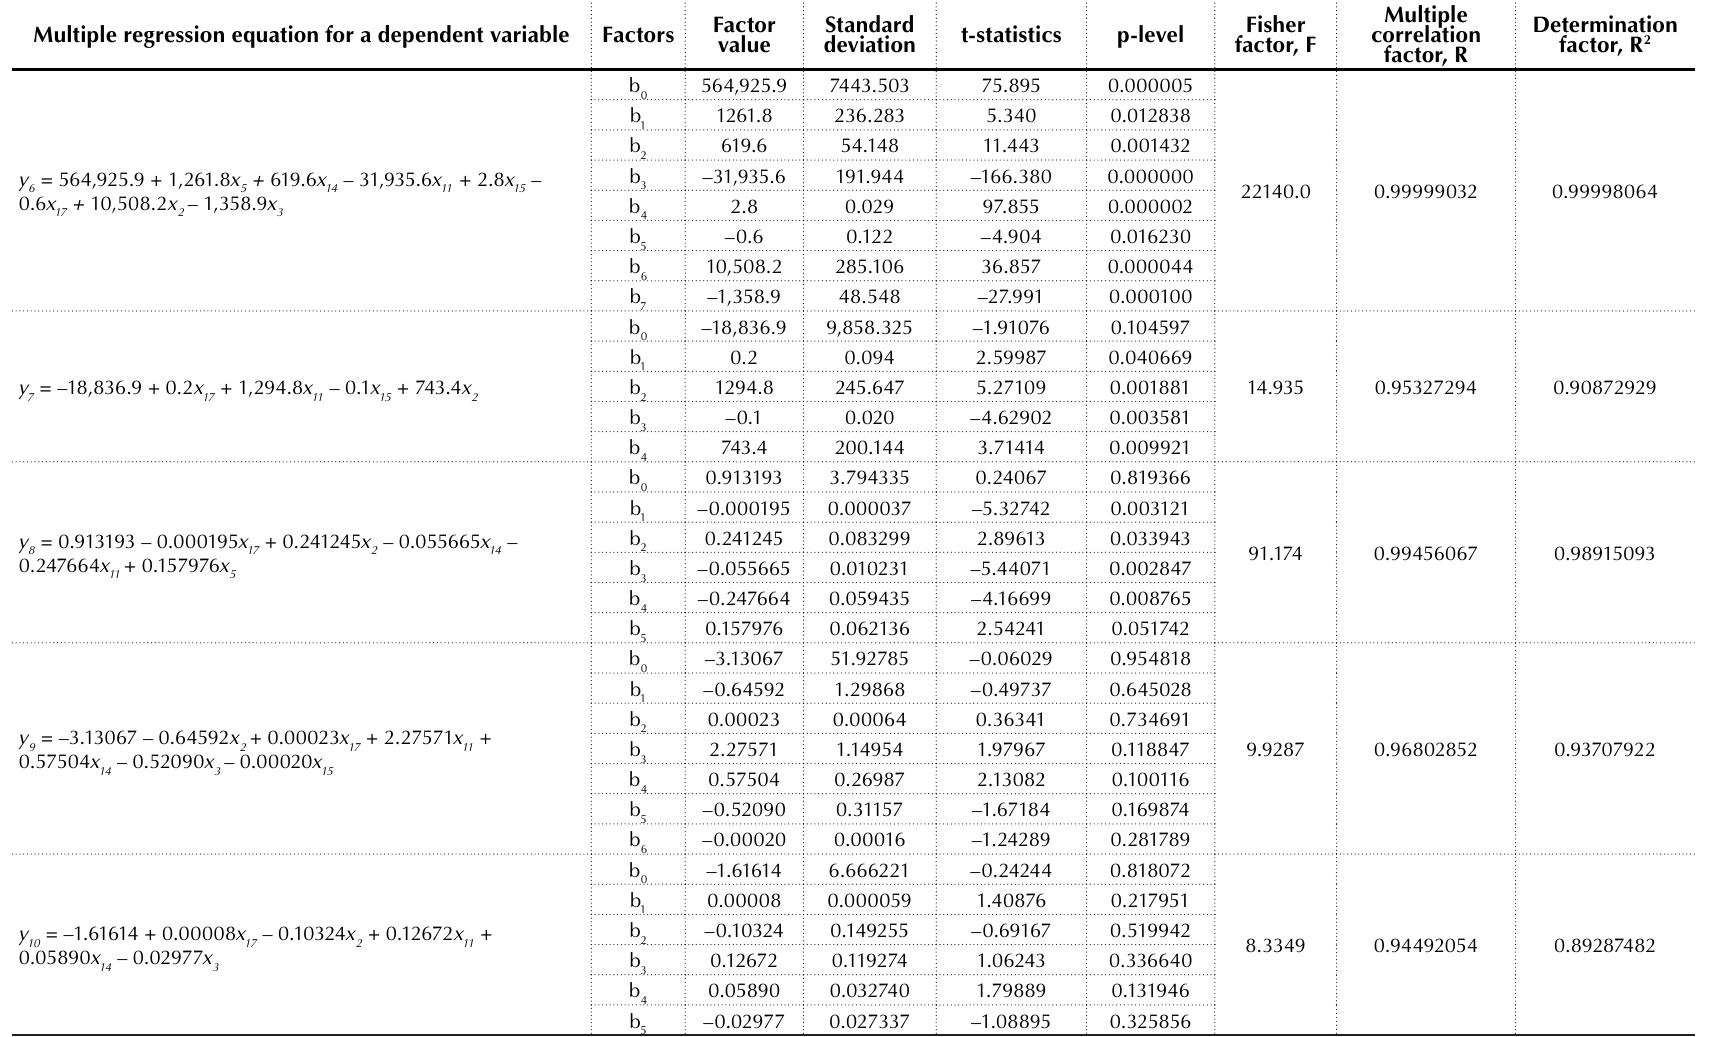
Table 5A (cont.). The statistics of the model of researching the change of financial and economic security indicators under the influence of foreign banking